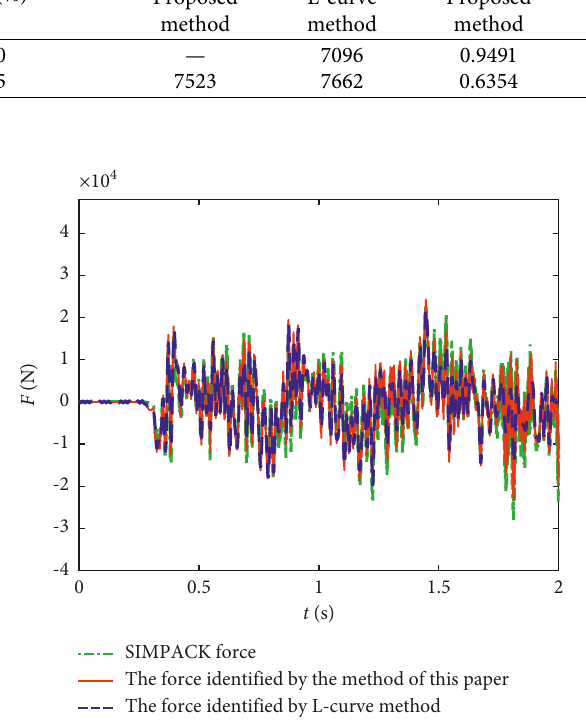
Figure 29: Load time-history diagram of the two methods for F identification when the noise level is 0%.